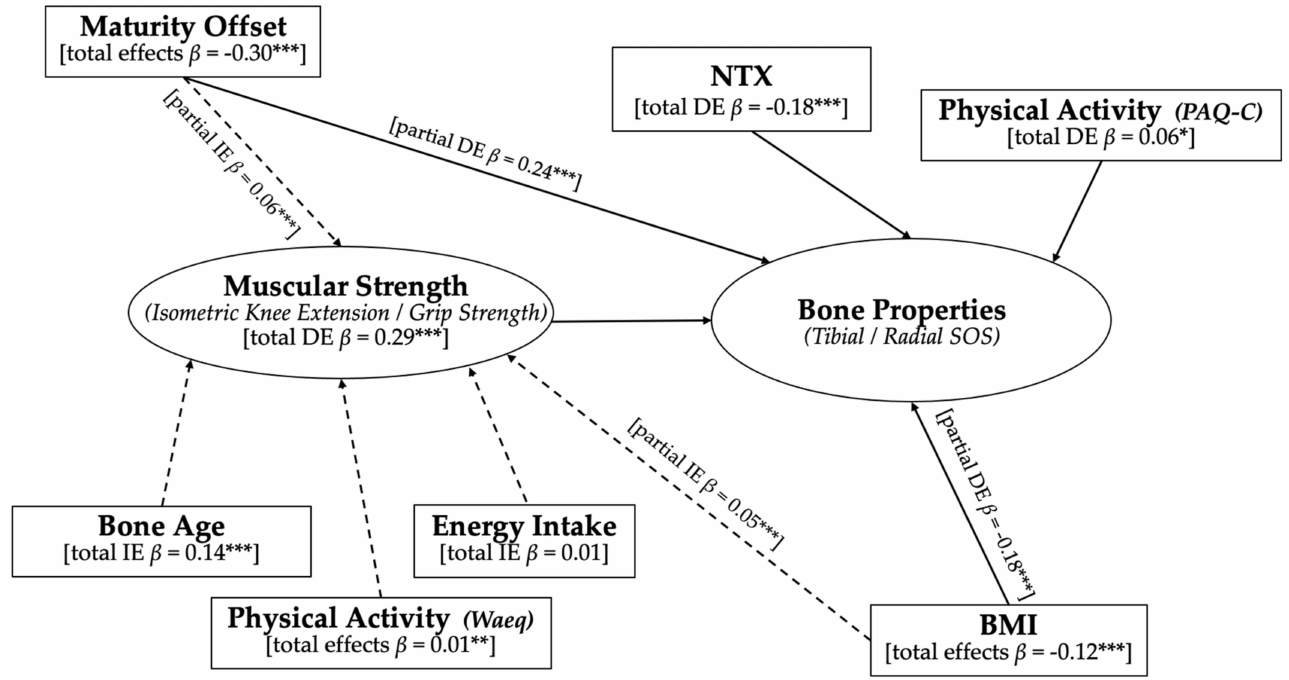
Figure 2. Diagram representing empirical results supporting the modified functional model of bone development in children and adolescents (total cohort). Solid arrows show direct effects (DE) of modulators on bone properties. Dashed arrows represent the indirect effects (IE) of modulators on bone properties that are either fully or partially mediated by muscle strength. * denotes p < 0.05; ** denotes p < 0.01; *** denotes p < 0.001. NTX = cross-linked N-telopeptides of bone type I collagen; PAQ-C = physical activity questionnaire for children; PHV = peak height velocity; BMI = body mass index; WAeq = weekly leisure time physical activity metabolic